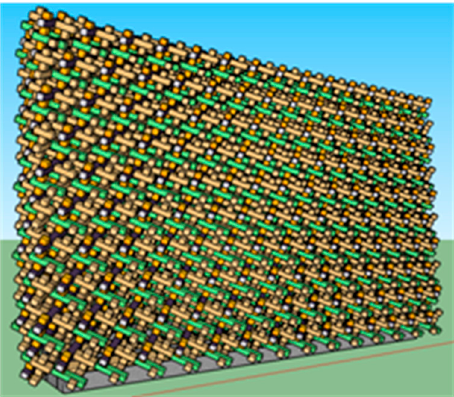
Figure 4. The virtual reconstruction of the wooden wall for assembling purpose.